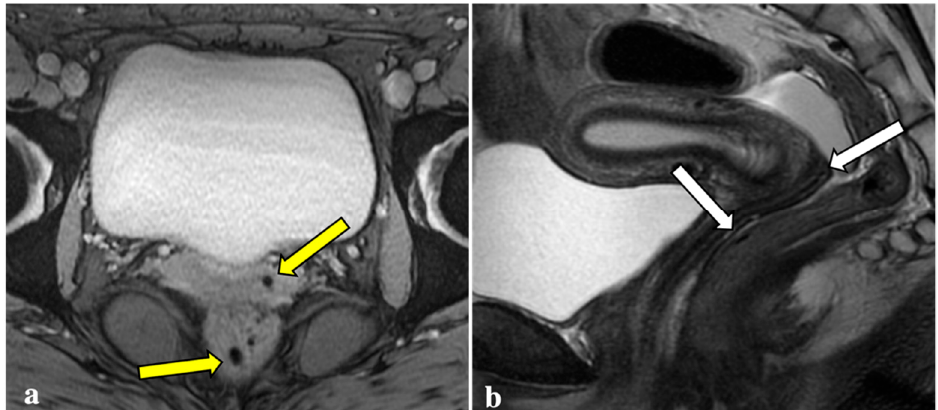
Figure 2. T2*-weighted imaging pitfall. Signal voids (yellow arrows) on T2*-weighted imaging ( a ) of a 24-year-old patient were subsequently related to artefacts caused by air within the vaginal fornix and the rectal lumen (white arrows), as shown in a sagittal T2W image ( b ).